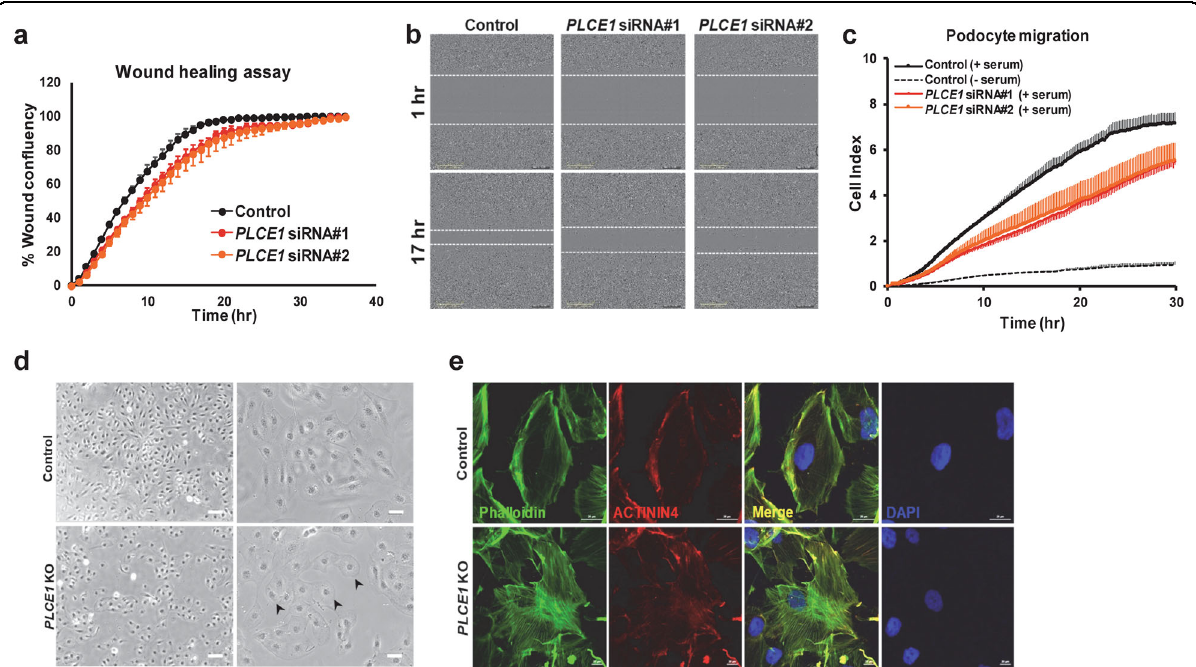
Fig. 4 Depletion of PLCE1 resulted in decreased podocyte migration and changed cell morphology. a Wound closure was reduced in podocytes transfected with PLCE1 siRNAs (red and orange dots) compared to that in control podocytes (black dots). b Movement of cells into the wound is shown at 1 and 17 h after scratching. PLCE1 knockdown podocytes showed delayed wound closure. c The effect of PLCE1 knockdown on serum-induced podocyte migration. Podocytes transfected with PLCE1 siRNA (red and orange lines) exhibited decreased migration compared to that of the control podocytes (solid black line). Error bars are shown in only one direction for clarity and indicate standard deviations for more than three independent experiments. d , e The effect of PLCE1 knockout (KO) on podocyte morphology. PLCE1 KO resulted in the loss of terminal arborizations in undifferentiated podocytes ( d ) and an increased number of stress fi bers in differentiated PLCE1 KO podocytes relative to that in control podocytes ( e